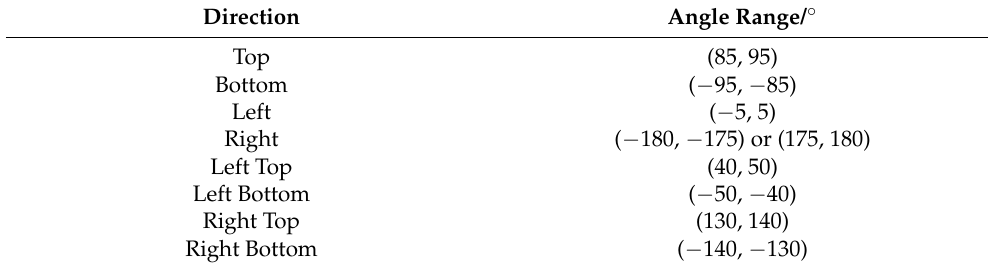
Table 1. Gear and angle